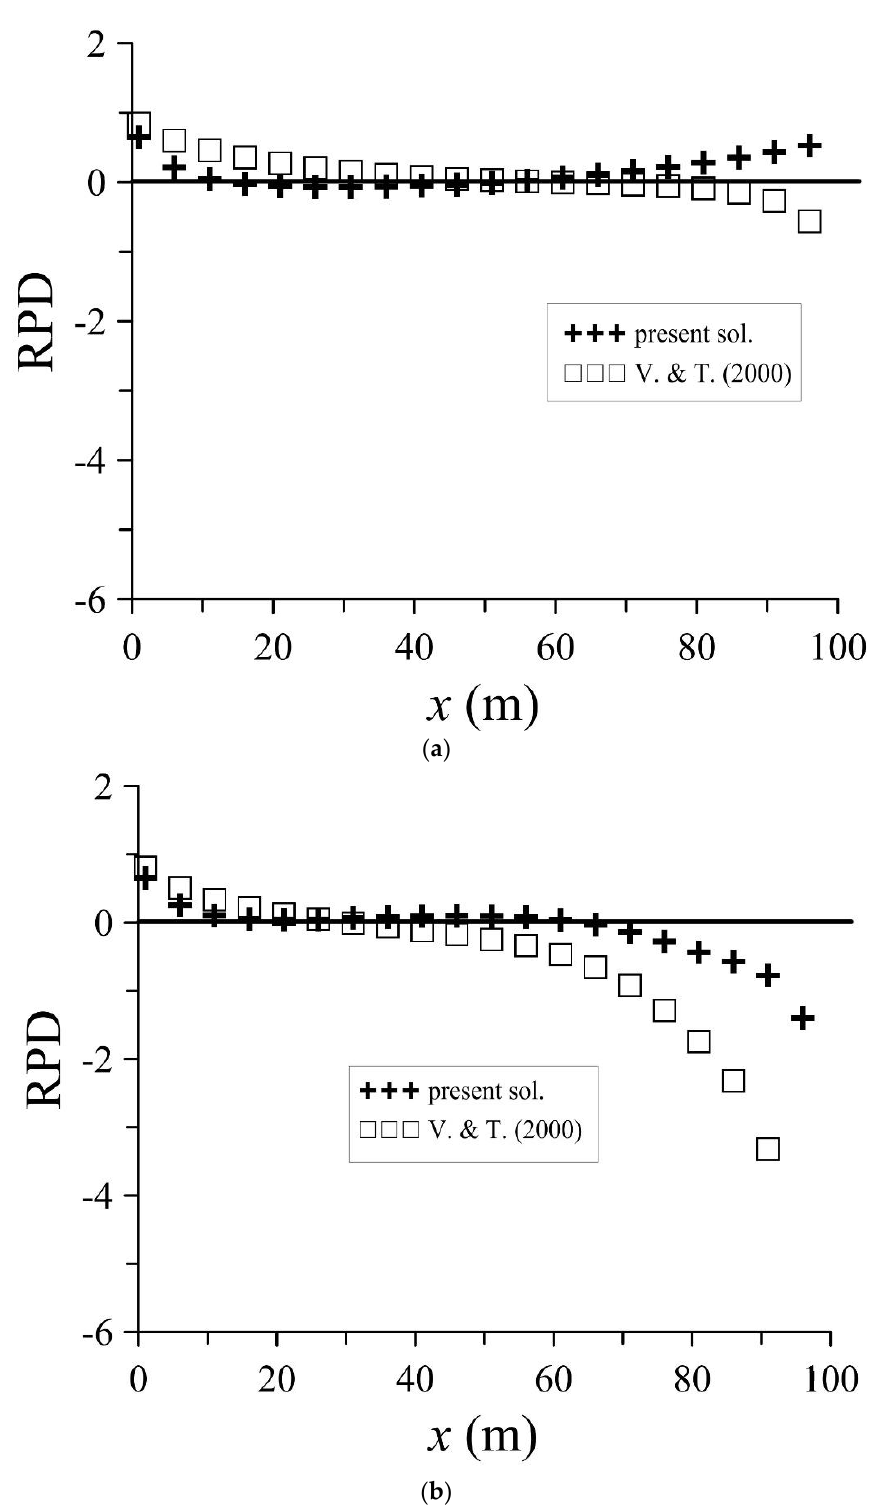
Figure 6. RPD between analytical and numerical solutions. ( a ) 𝜃 = 2° ( b ) 𝜃 = 6° ( t = 3 days).